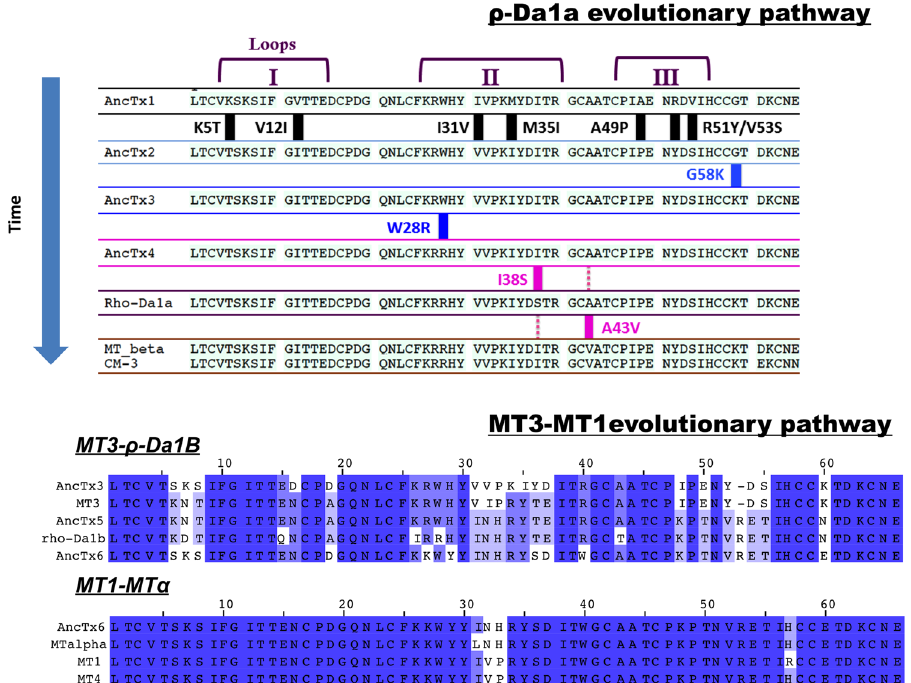
Figure 3. Amino acid substitutions in the aminergic toxins and their ancestors from the two evolutionary pathways. Sequences are following the time/tree topology of the aminergic toxins. MT7 and MT2 sequences are not shown in the ρ -Da1a pathway due to divergences in sequence and function. Amino acid substitutions are highlighted in the first pathway. MT1-MT3 evolutionary pathway is also illustrated. Color display is settled in order to emphasize amino acid conservation along the toxins. Stronger blue color indicates residue conservation among all